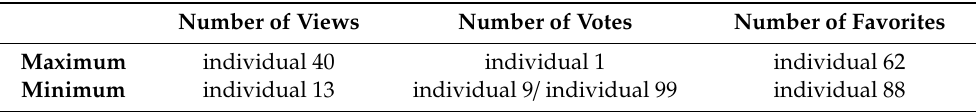
Table 4. Maximum and minimum of doctor interaction frequency.